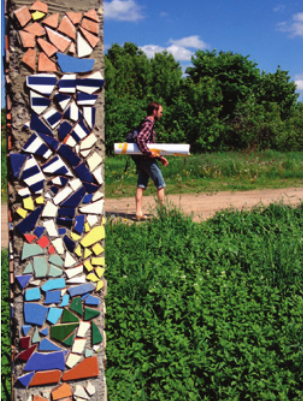
Fig. 3. One of the utility poles, decorated during the Street Mosaic Workshop. A fragment of “Street Mosaic Route”